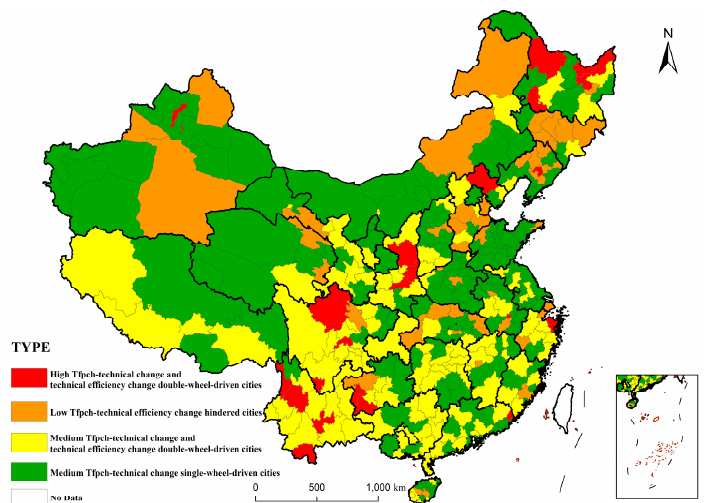
Figure 7. Four types of Agricultural Tfpch spatial clustering analysis.